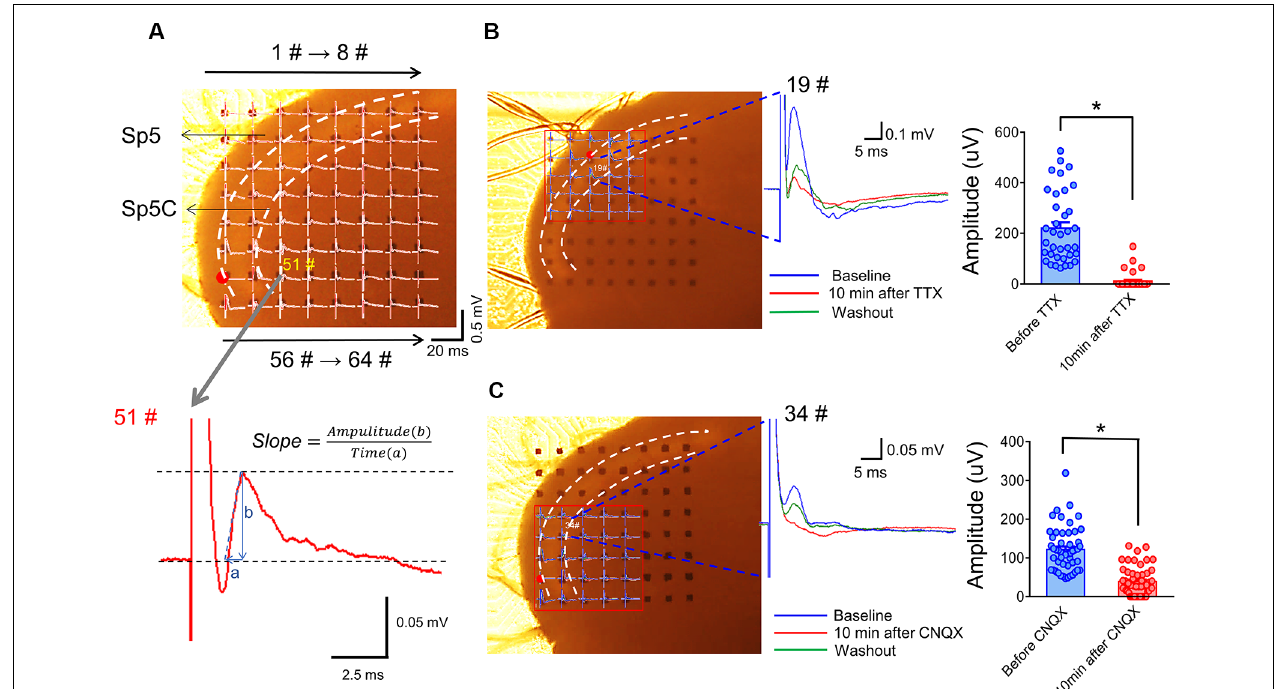
FIGURE 4 | Arrangement of an acutely dissociated medullary dorsal horn slice on an MEA recording dish and pharmacological identification of evoked network local field potentials (eLFPs). Panel (A) shows a typical example of the MEA (8 × 8, 64 electrodes) recordings on a rat medullary dorsal horn (Sp5C) slice. The upper panel shows representative network traces of eLFPs recorded across the 63 sites following electrical stimulation at the spinal tract of the trigeminal nerve (Sp5, red dot for #49). The vertical scale indicates the amplitude of potentials (0.5 mV), horizontal scale indicates the time (20 ms). The lower panel showing a typical waveform of eLFPs recorded from 51# electrode (gray arrow), the slope was calculated as the ratio of amplitude (b) to a time interval (a). Panel (B) shows blocking effect of eLFPs by perfusion with TTX (1 µ M; dots mean 36 electrode points from n = 6 slices). Panel (C) shows the suppressive effect of eLFPs by perfusion with CNQX (10 µ M; dots mean 66 electrode points from n = 8 slices). * p < 0.05 , drug vs. baseline. Error bars: ±